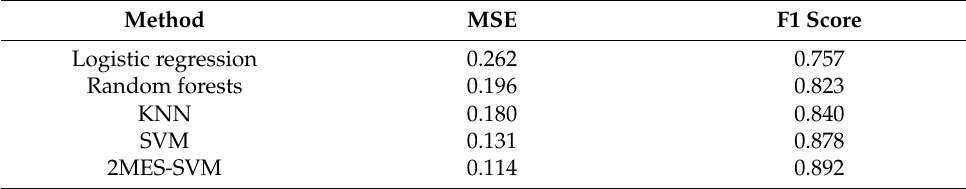
Table 1. The classification performance. Cleveland